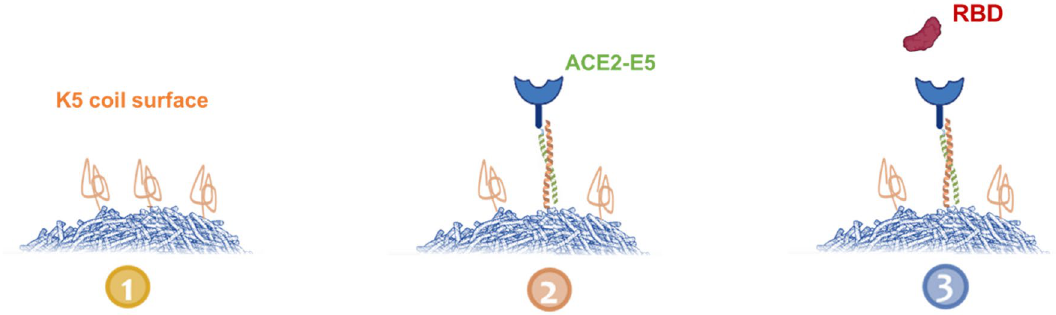
Figure 1. Representation of our three-step SPR-based assay with capture of E5 coil tagged ACE2 (ACE2-E5) by a K5 coil